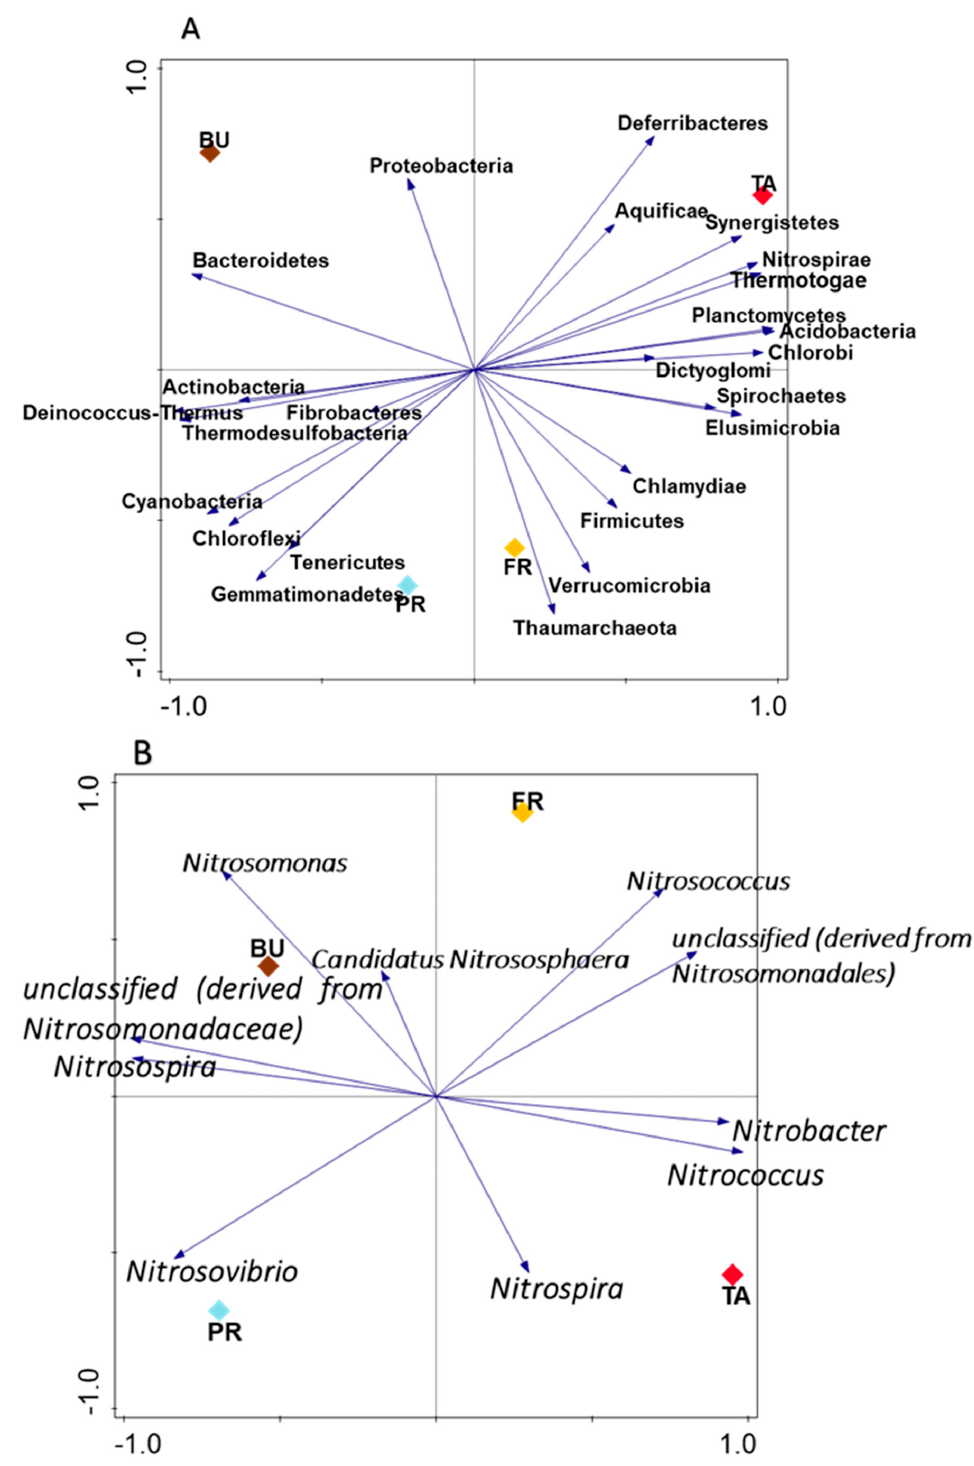
Figure 4. Principal component analysis (PCA) of nitrifying bacteria and archaea group 16S amplicon sequence. The resultant vector showed the structural shift and the influence of nitrifying bacteria and archaea. Axis 1 and 2 explained the observed variation based on Euclidean dissimilarity matrix.